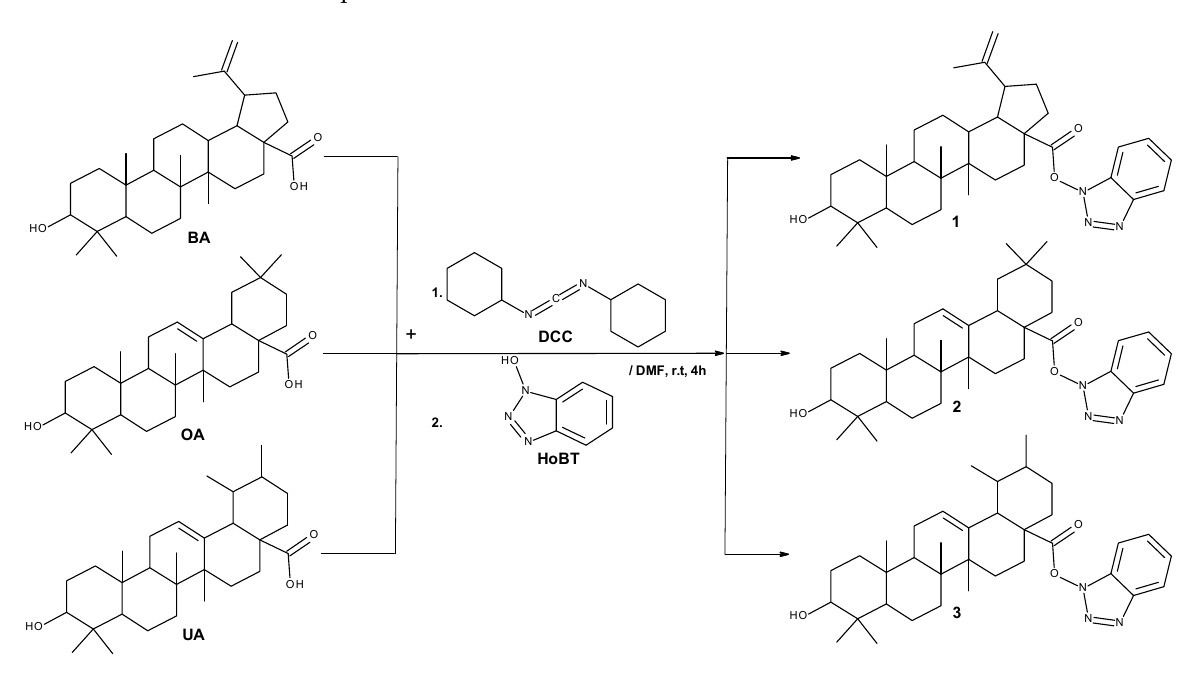
Figure 1. Synthesis procedure of BA, OA, and UA-HOBt esters ( 1 – 3